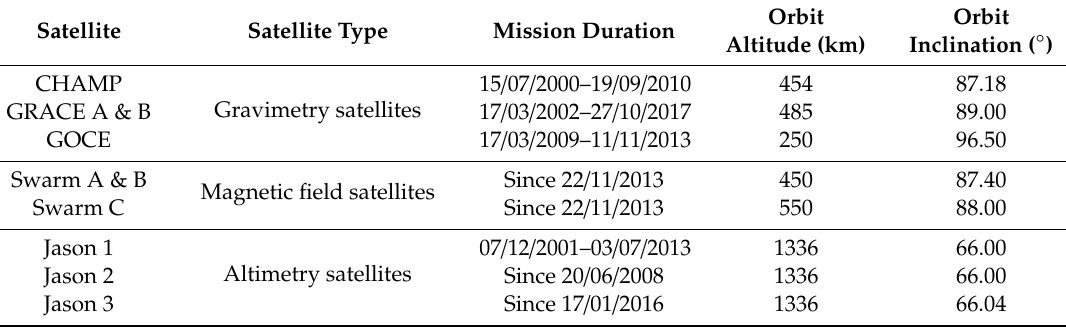
Table 1. Basic information on the satellites that were used by ITSG to develop temporal models of Earth gravity field: satellite type, mission duration, and orbit altitude and